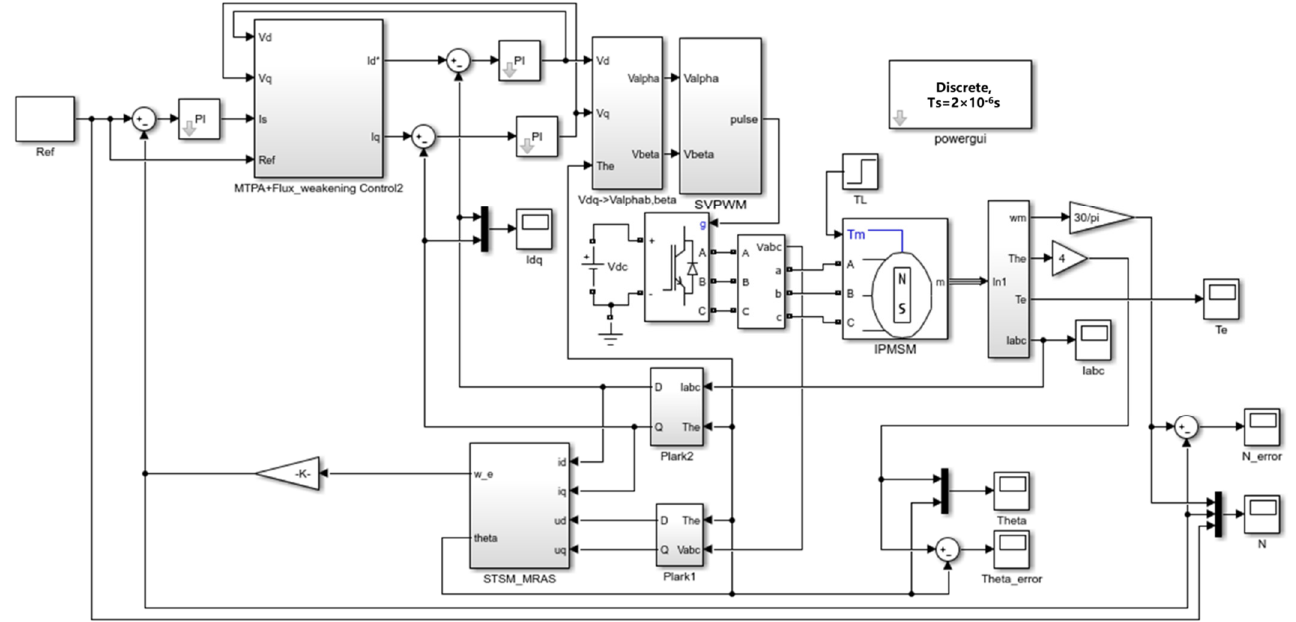
Figure 9. Simulation model of STSM − MRAS control system.